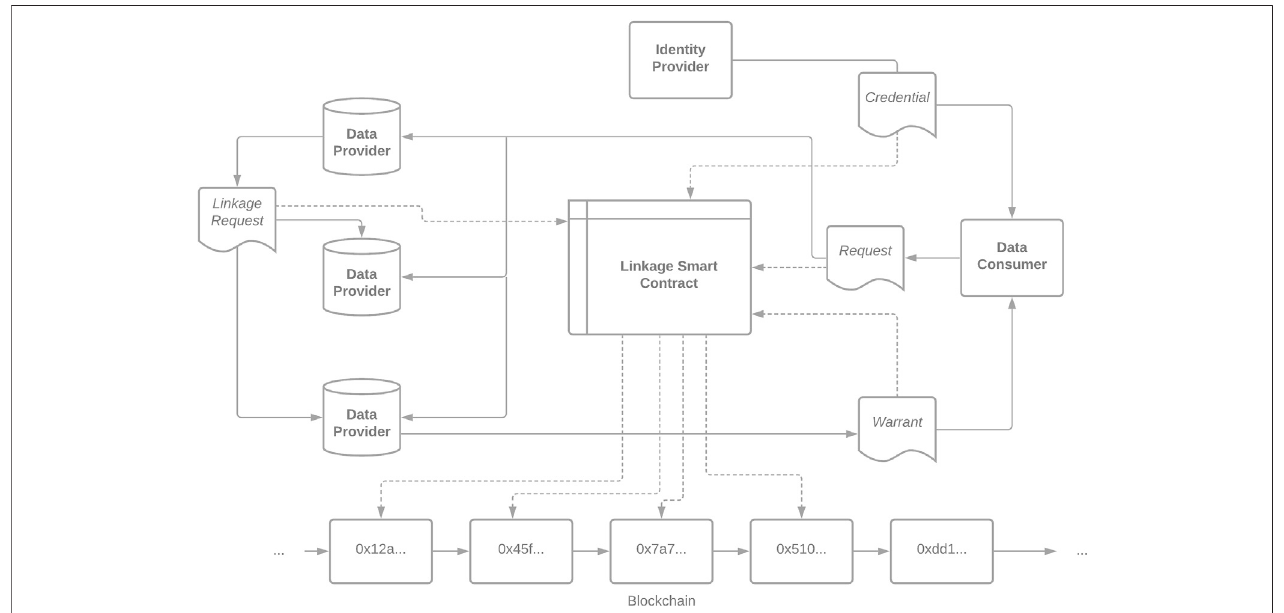
FIGURE 1 | A Reference Architecture For Blockchain Native Data